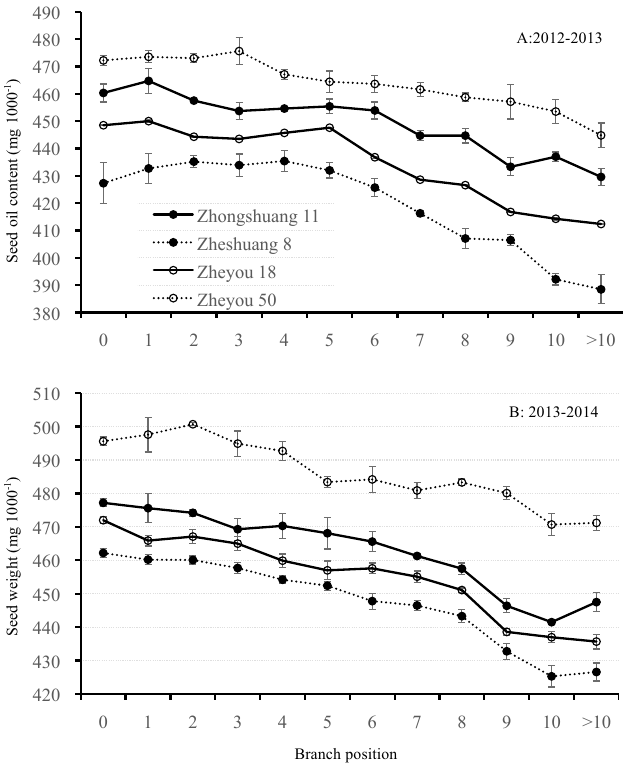
Fig. 2: Seed oil content in the main inflorescence and different branches from the top to the bottom of the main stem in the four